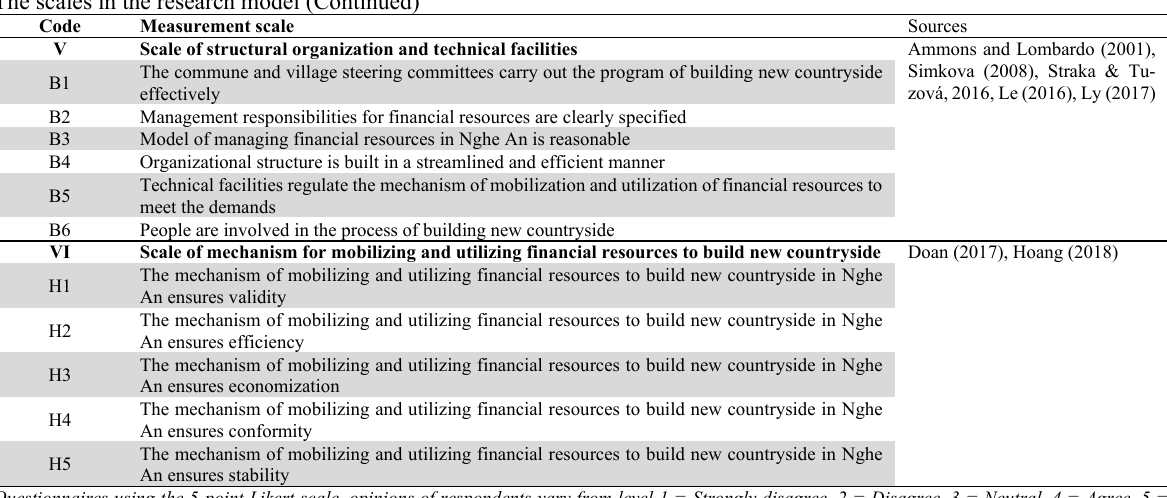
The minimum correlation coeffi- cient of total